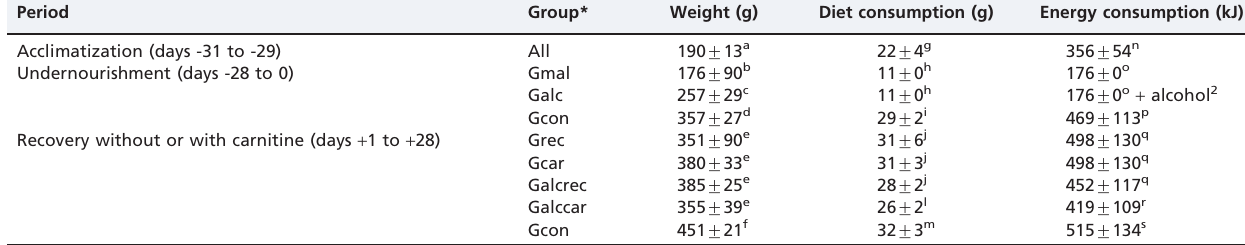
Table 1 - Weight, diet consumption, and calorie consumption by the animals after the different experimental periods. 1